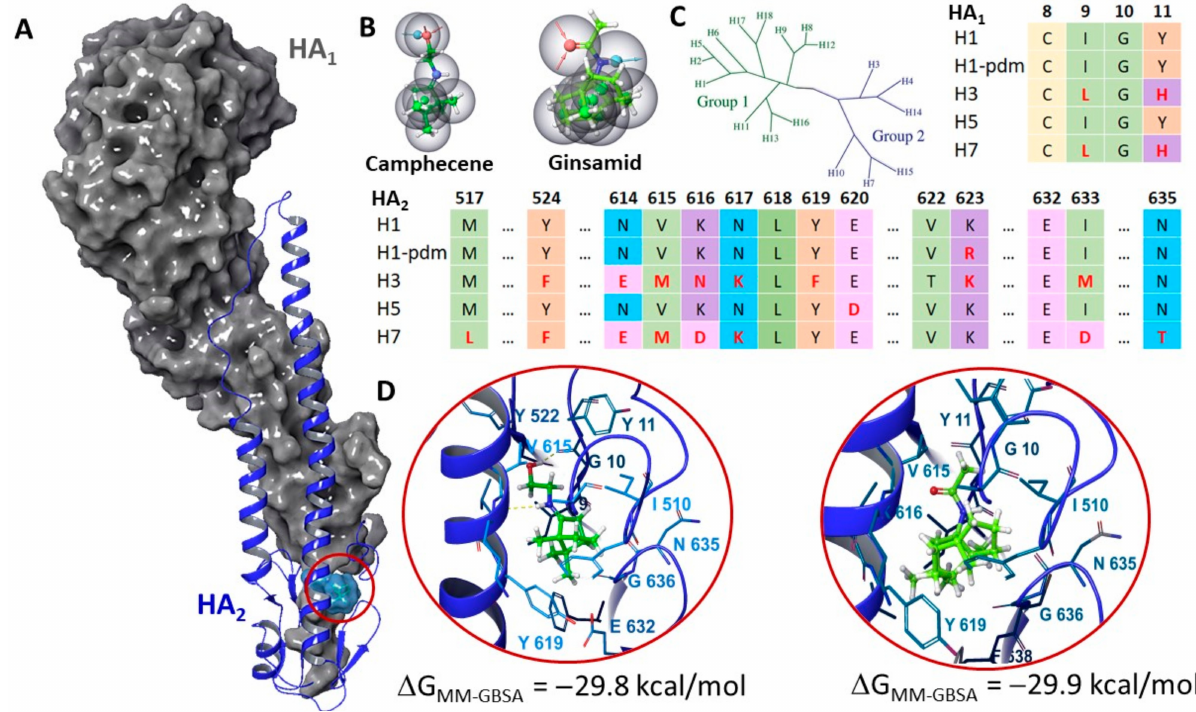
Figure 11. Molecular modeling results: ( A ): Monomer of HA: gray surface corresponds to HA1; blue secondary structure: HA2. ( B ): Pharmacophore profiles of Camphecene and Ginsamide: hydrophobic descriptors are represented by green balls; acceptor—by red, and donor—by light-blue ones; ( C ): Phylogenetic tree of influenza A HAs [47] and results of binding site alignment procedure H1 (PBD code 1RU7 [55]; H1-pdm (PBD code 3LZG [58]); H3 (pdb code 3EYM [47]); H5 (PDB code 6CF5 [59]) and H7 (PBD code 6ID2 [60]). Amino acids differences are written in red letters. ( D ): Molecular docking result: H-bonds are represented with yellow dotted